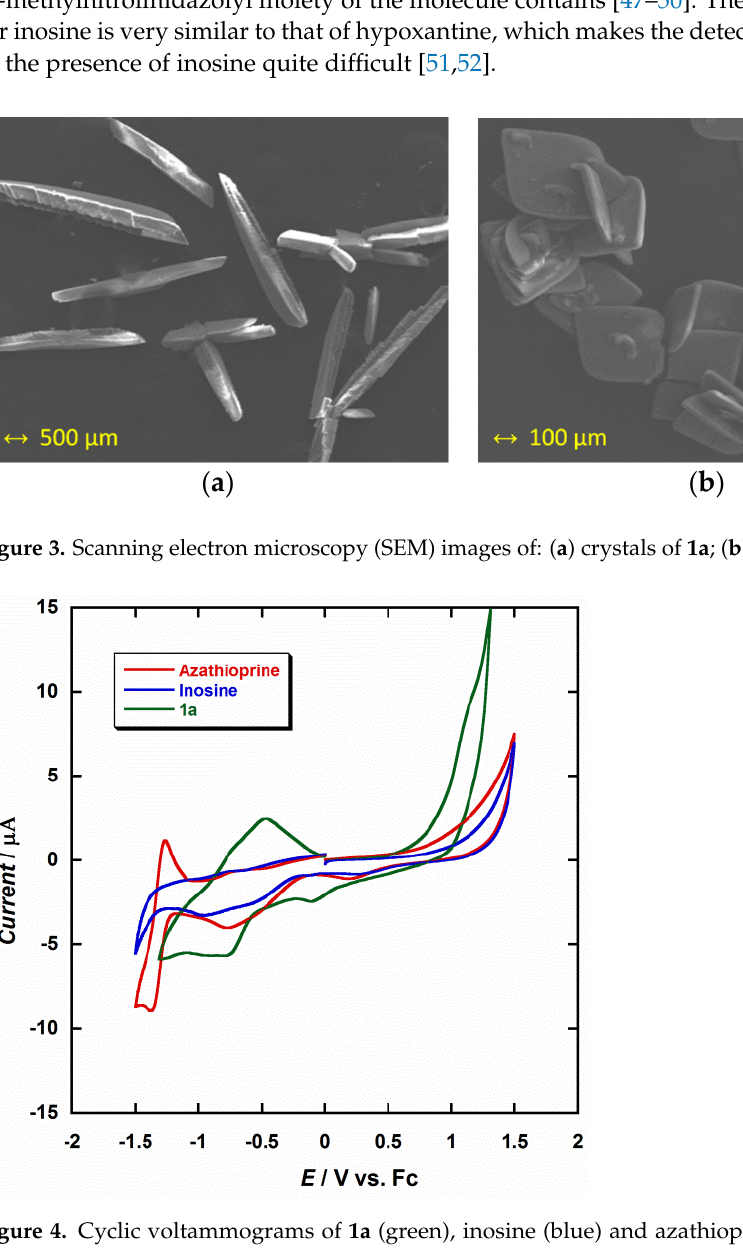
Figure 3. Scanning electron microscopy (SEM) images of: ( a ) crystals of 1a ; ( b ) crystals of 1b .